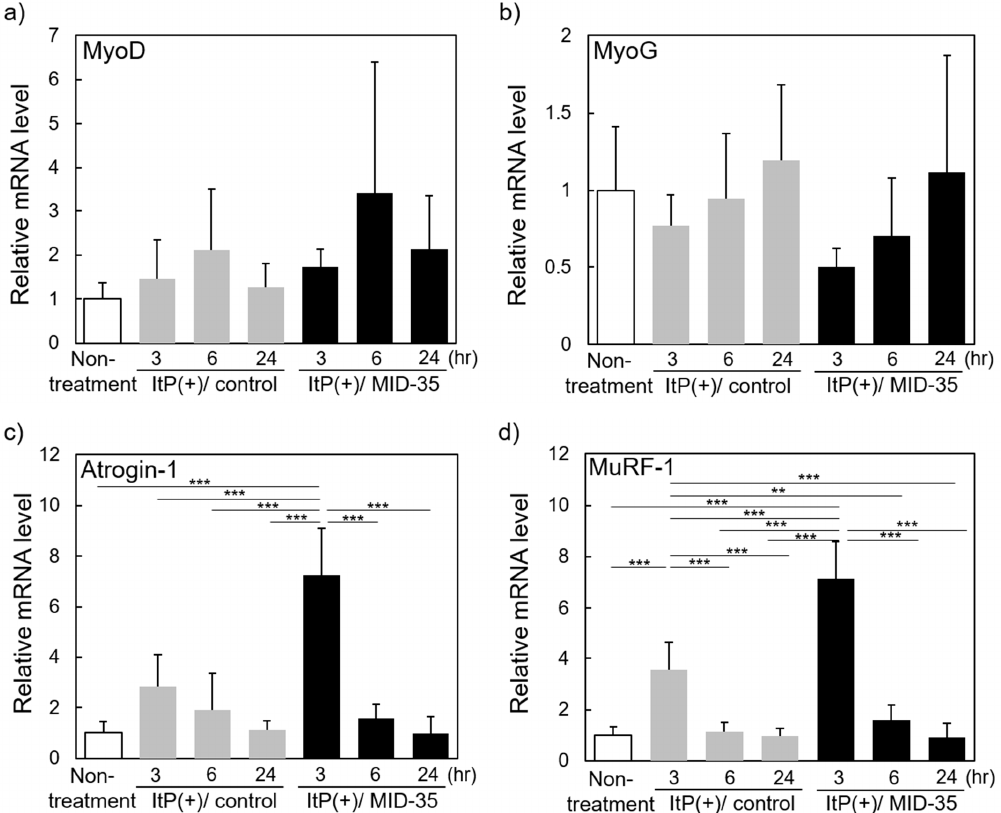
Figure 6. Effect of ItP of MID-35 on the expression of genes related to muscle growth: RNA was extracted from tibialis anterior muscle of the mice at 3, 6 and 24 h after ItP of MID-35. The mRNA levels of ( a ) MyoD, ( b ) MyoG, ( c ) Atrogin-1 and ( d ) MuRF-1 were quantified by real-time RT-PCR. The values are shown as means ± SD from at least three independent experiments. ** p < 0.01, *** p < 0.001